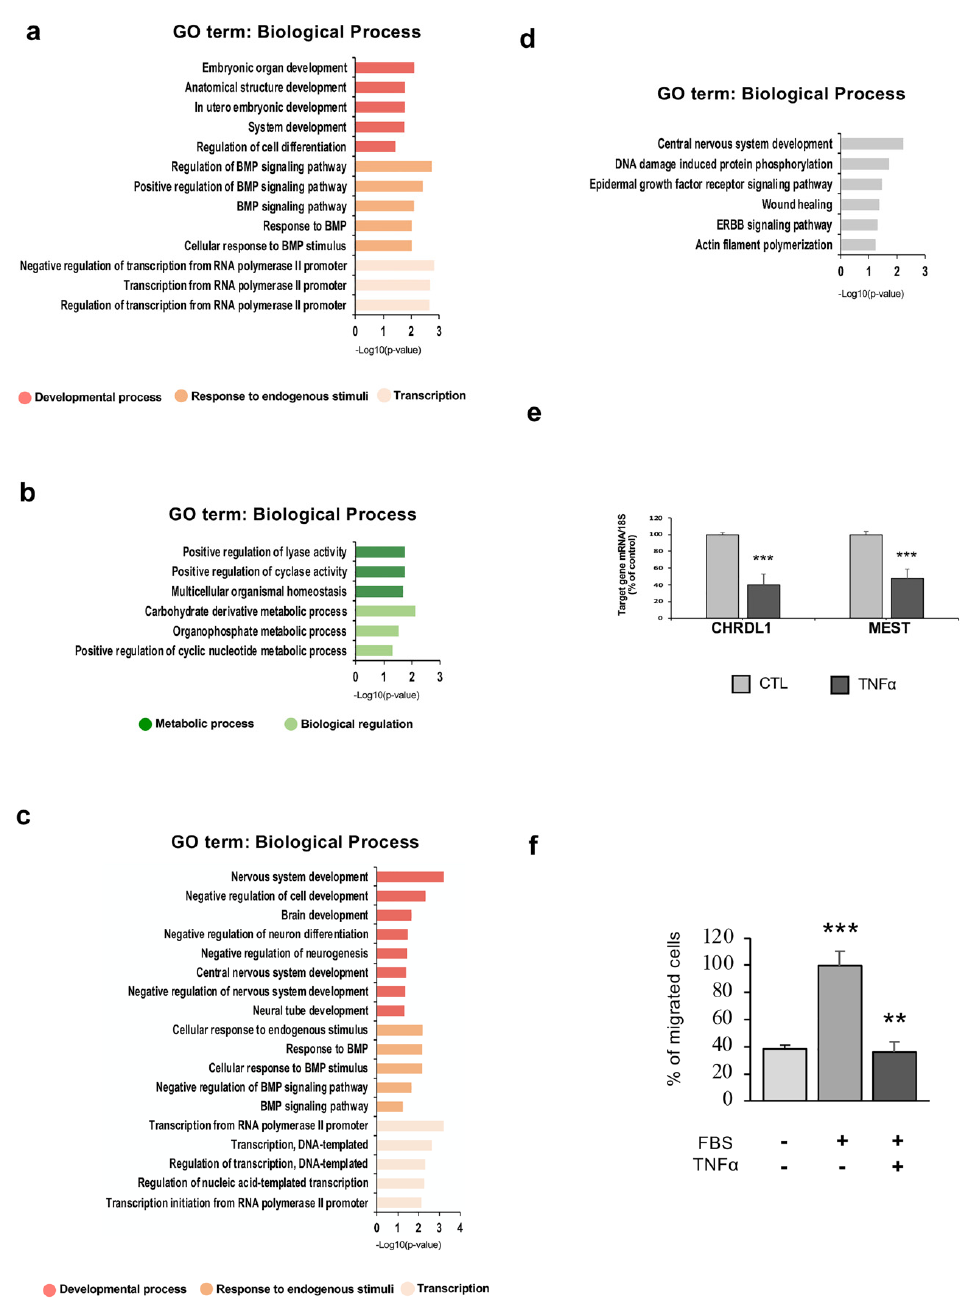
Figure 6. Functional analysis of DNA methylation changes in TNF α‐ treated hfNBMs. ( a – d )